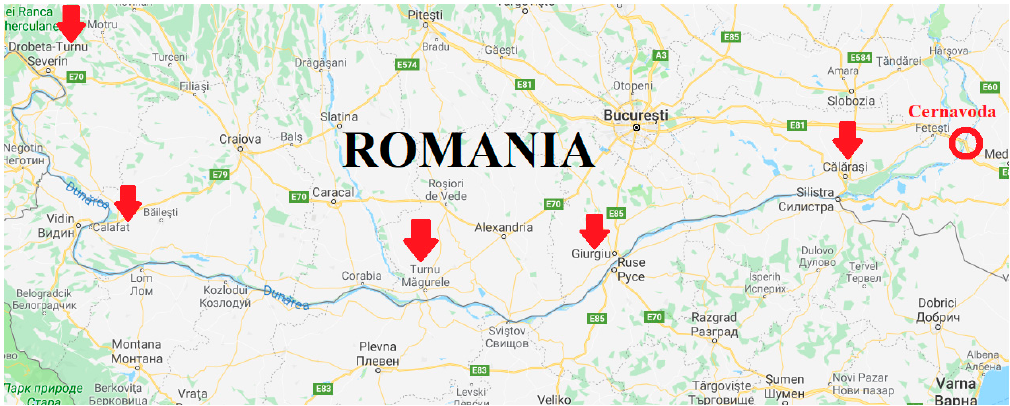
Figure 1. The towns crossed by the ship on each day of travel.